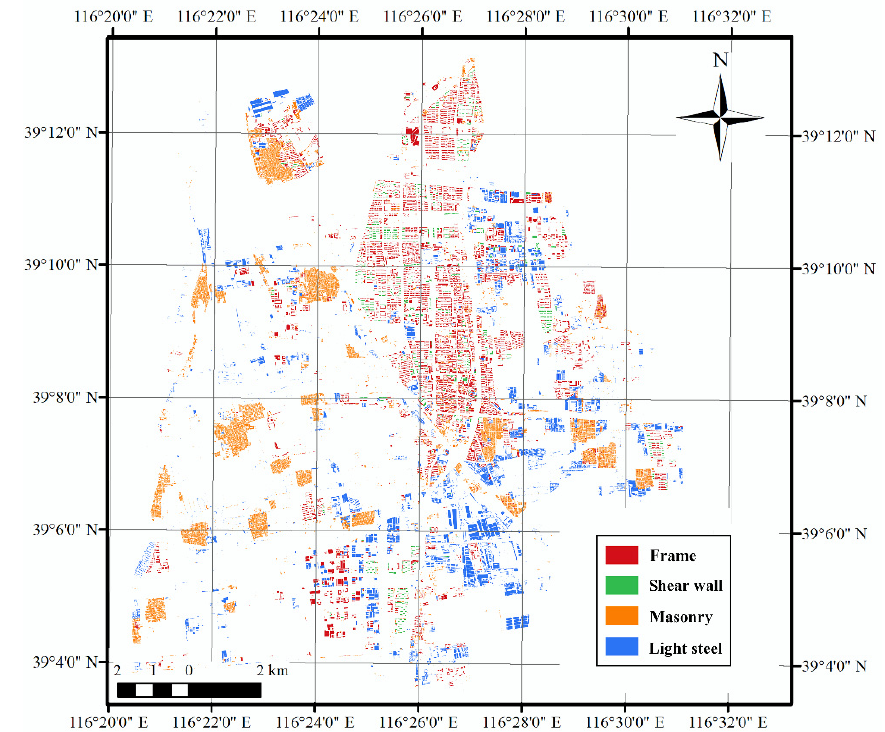
Figure 23. Distribution of building structure type in Daxing downtown.